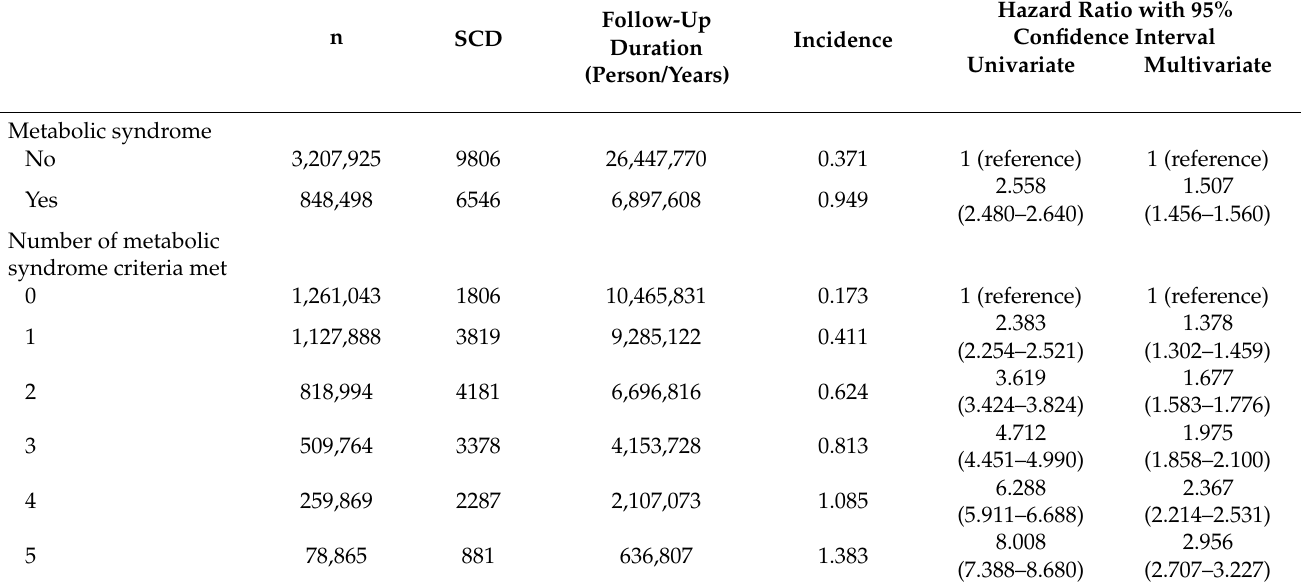
Table 3. Impact of metabolic syndrome on SCD.